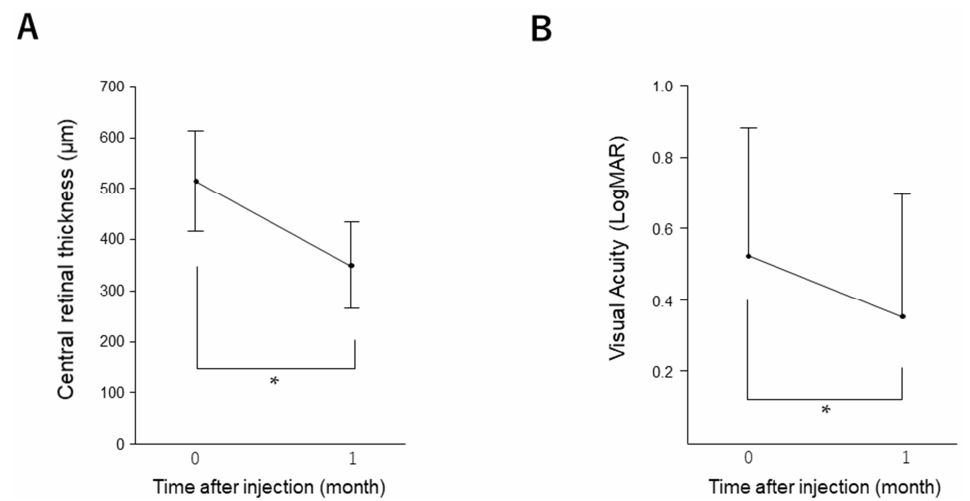
Figure 1. Changes in CRT and BCVA after injection of anti-VEGF agents. CRT ( A ) and BCVA ( B ) were measured 0 and 1 month after a single injection. BCVA is expressed as logMAR. Data are presented as mean ± standard deviation (SD). * p < 0.05 (versus baseline). CRT, central retinal thick- ness; BCVA, best-corrected visual acuity; VEGF, vascular endothelial growth factor; SD, standard deviation.